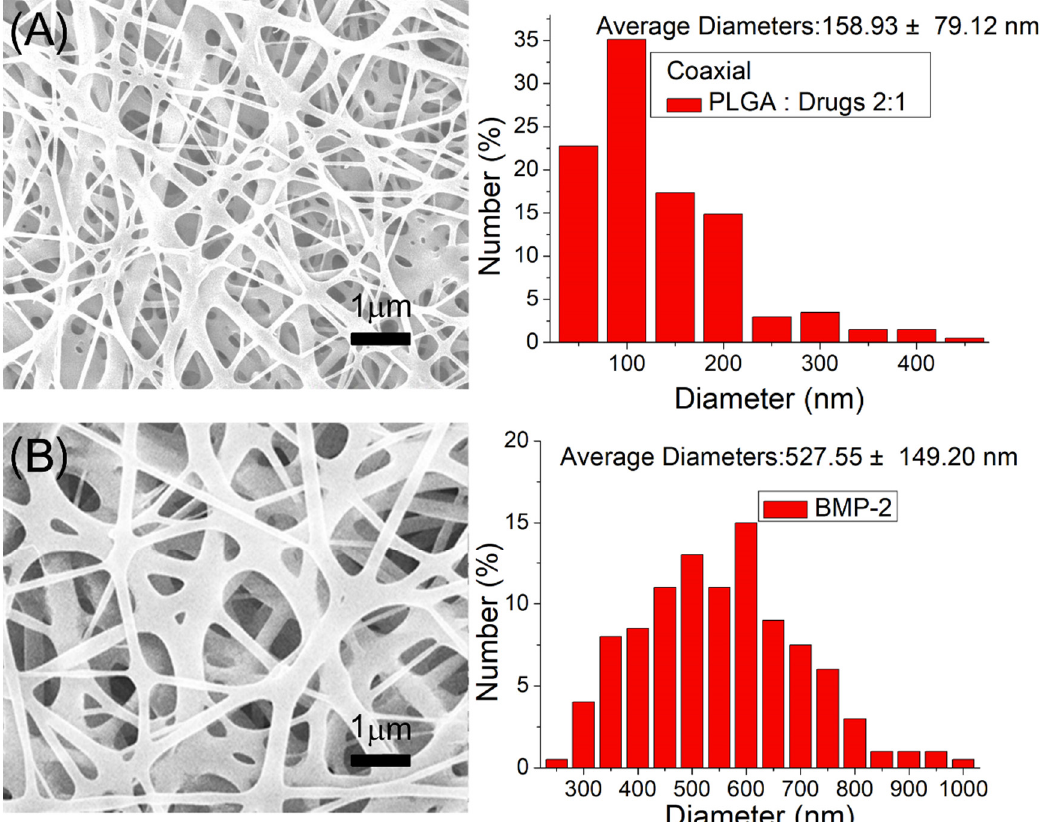
Figure 4. Scanning electron microscopy (SEM) images and fiber diameter distributions: ( A ) drug- loaded nanofibers, and ( B ) BMP-2-loaded nanofibers.